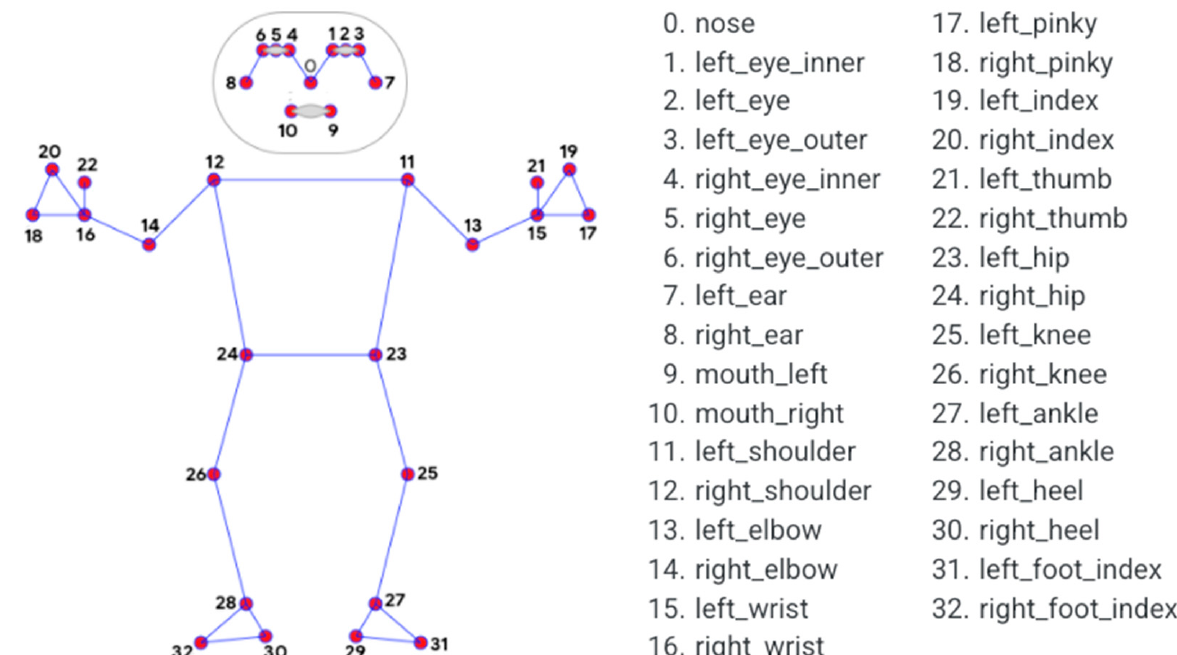
Figure 1. Definition of landmarks in MediaPipe Pose [22].